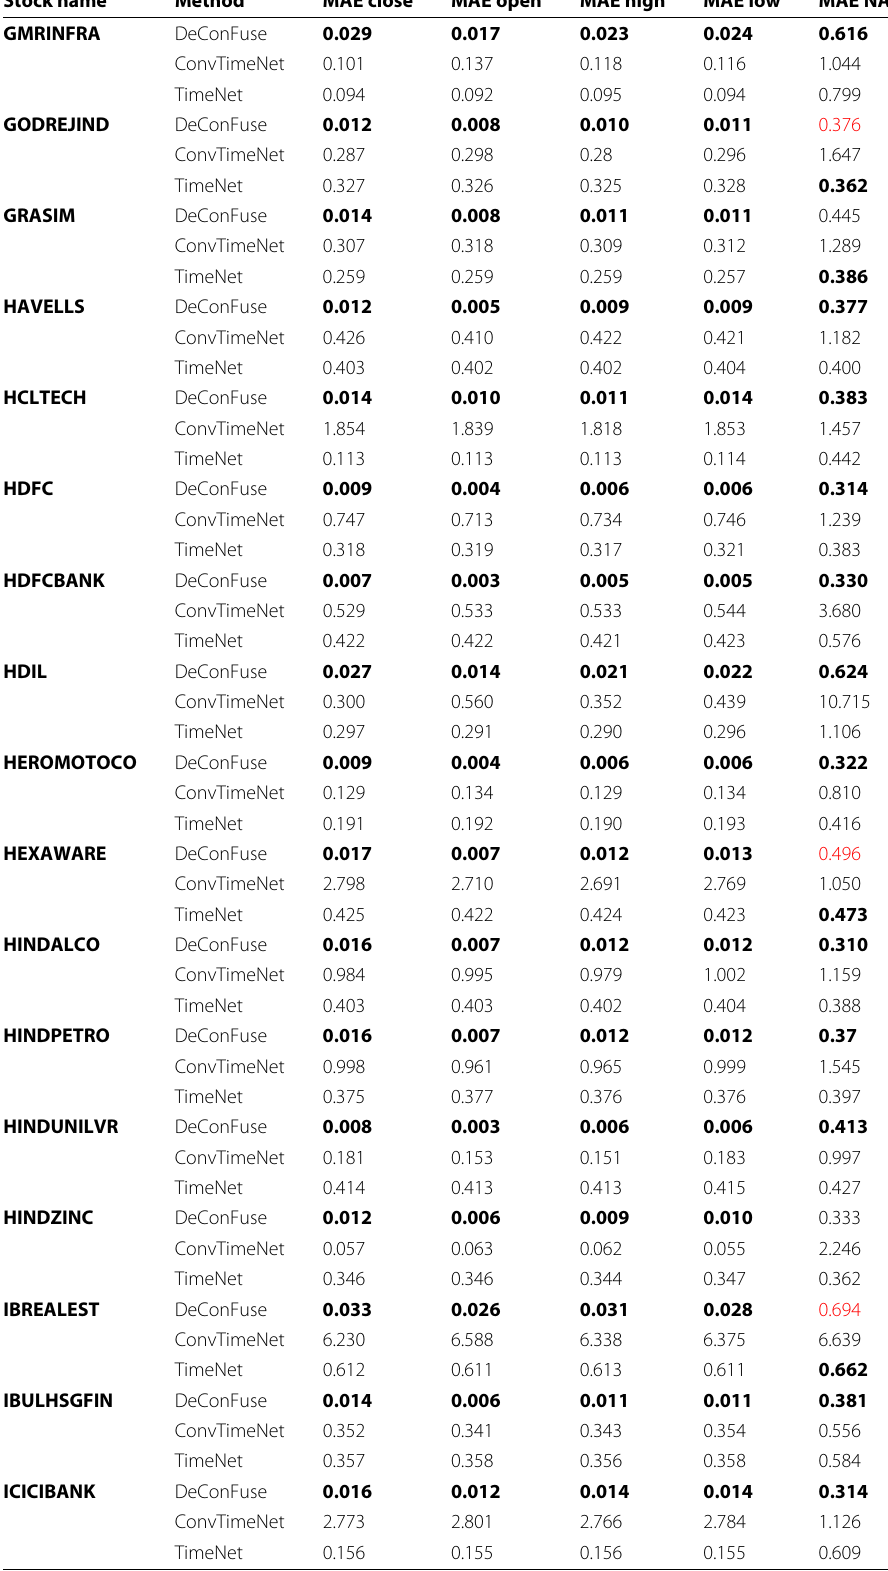
Table 5 Stock-wise forecasting results ( Continued